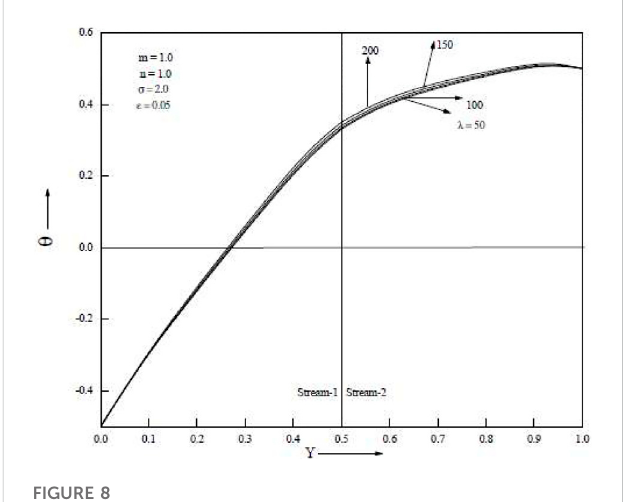
FIGURE 6 Velocity for various values of σ = 2, 4, 6, 8.